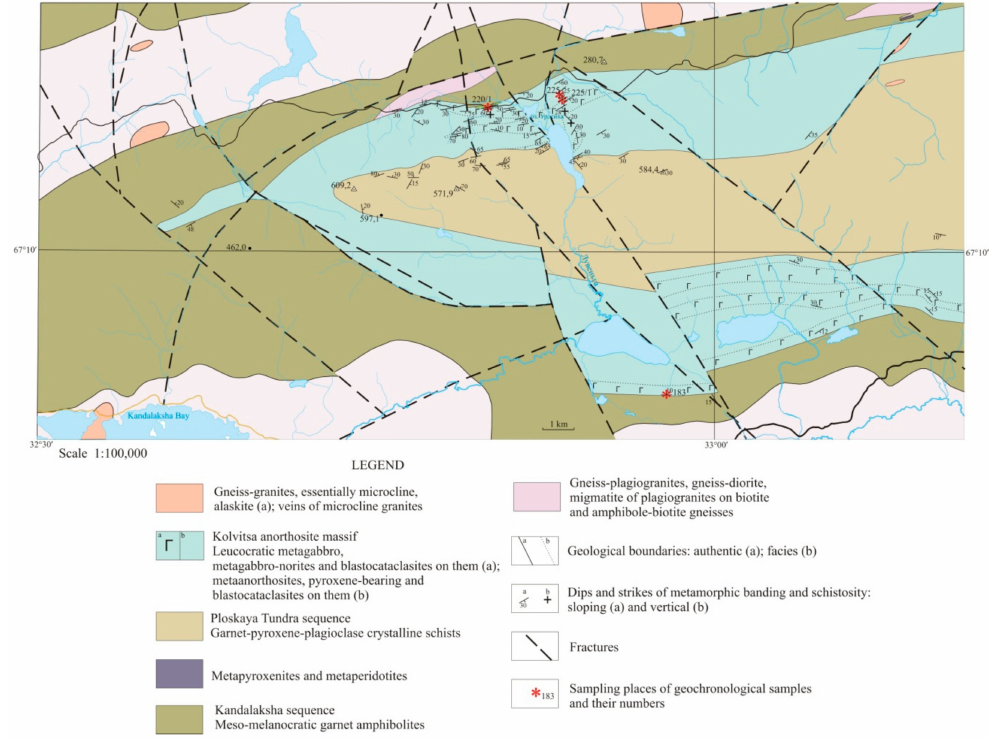
Figure 3. Scheme of the geological structure of the western part of the Kandalaksha anorthosite